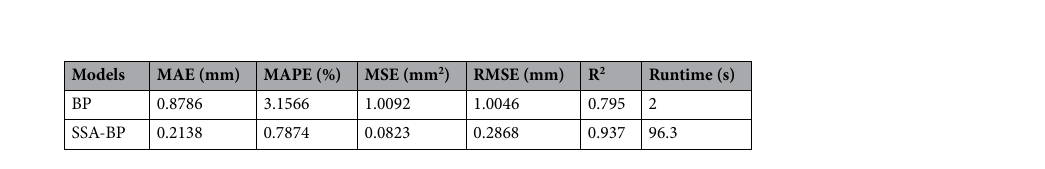
Table 3. Evaluation index value and average running time of BP, SSA-BP at P1.